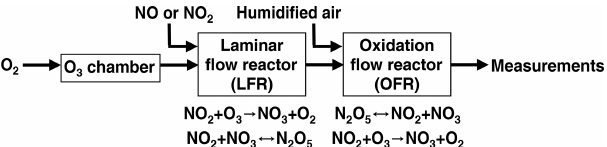
Figure 1. Process flow diagram of the OFR-iN 2 O 5 technique used to generate nitrate radicals (NO 3